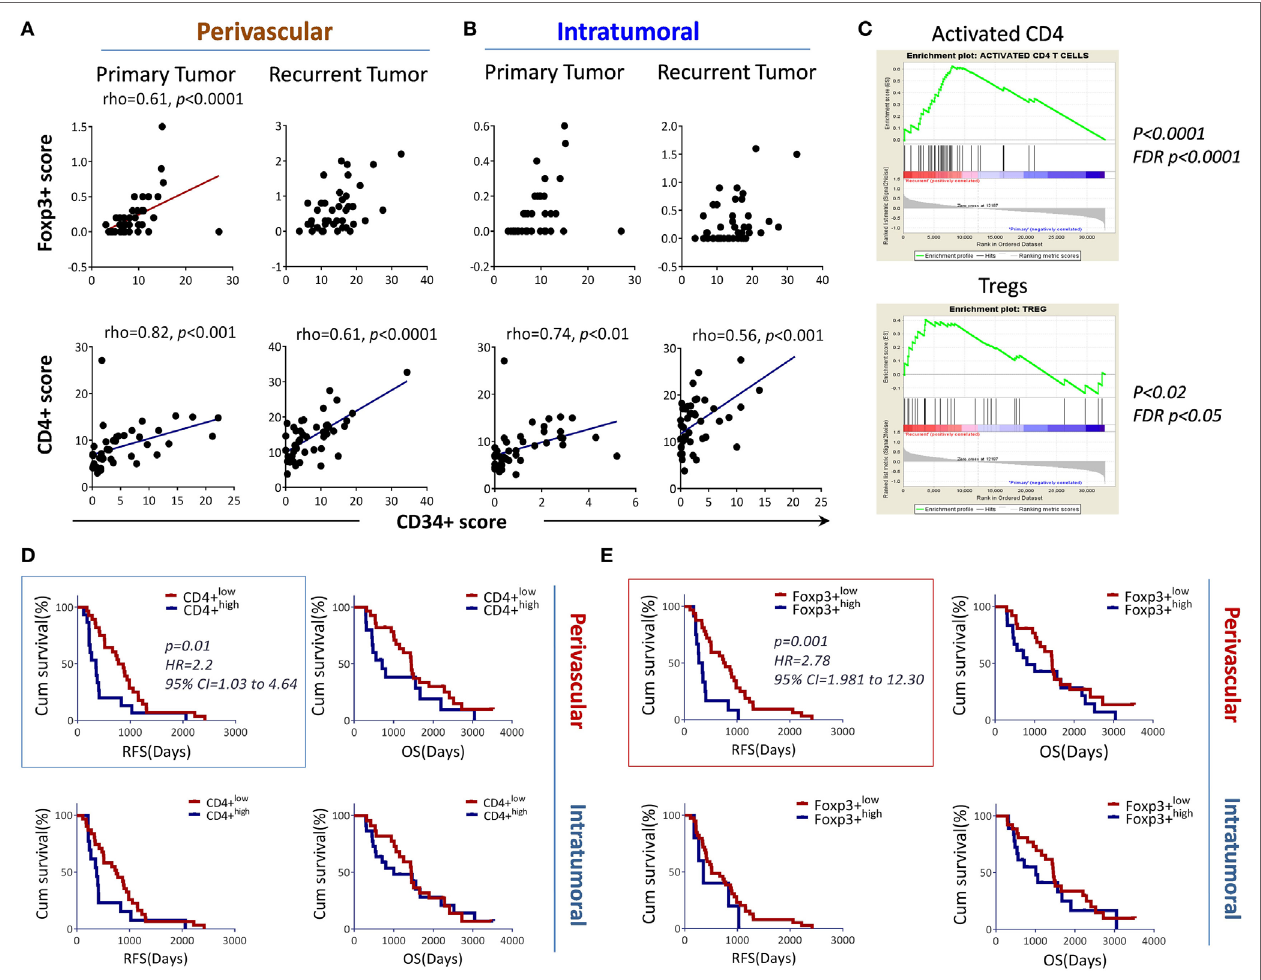
FigUre 5 | Perivascular Foxp3 + T cells associated with angiogenesis and tumor progression. (a,B) Perivascular Foxp3 + (upper panel) or CD4 + T cells (lower panel) were positively associated with CD34 + circles, respectively. (c) Regulatory T cells (Tregs) signature genes enriched by the tumor recurrence. The microarray data described in Figure S1 in Supplementary Material were input into Gene Set Enrichment Analysis (GSEA) for an analysis of activated CD4 T cells and Tregs. (D) Association of perivascular or intratumoral CD4 + T cells with RFS (left) and overall survival (OS) (right). (e) Association of intratumoral or perivascular Foxp3 + T cells with RFS and OS. The association between the markers and RFS, OS is shown using Kaplan–Meier survival curves, the median value was used for stratifying the low and high in each recurrent group. The log-rank test was used to compare the